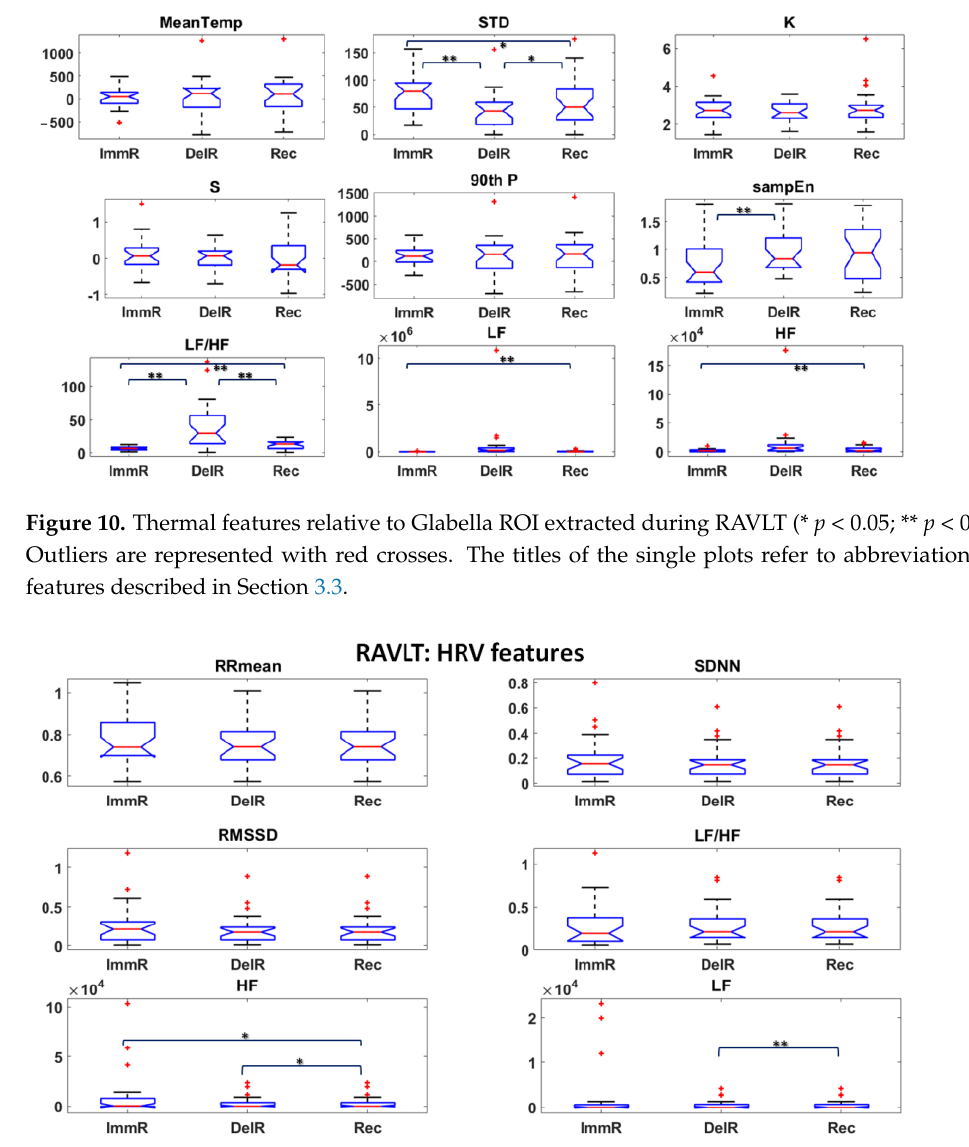
Figure 11. HRV features extracted during RAVLT (* p < 0.05; ** p < 0.01). Outliers are represented with red crosses. The titles of the single plots refer to abbreviations of features described in Section